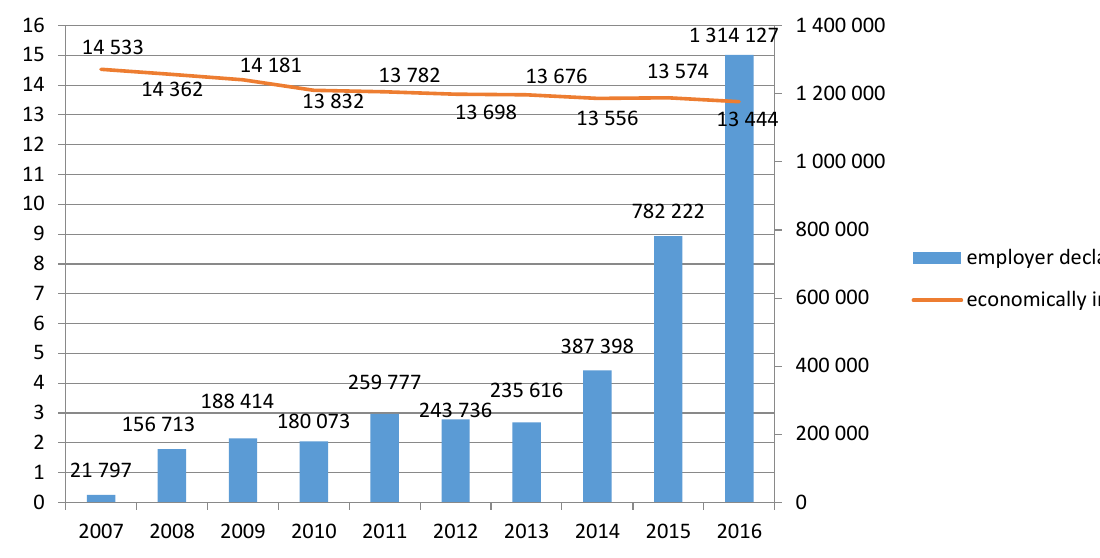
Figure 6. Declarations submitted (right axis) and the economically inactive population in millions (left axis) in Poland,